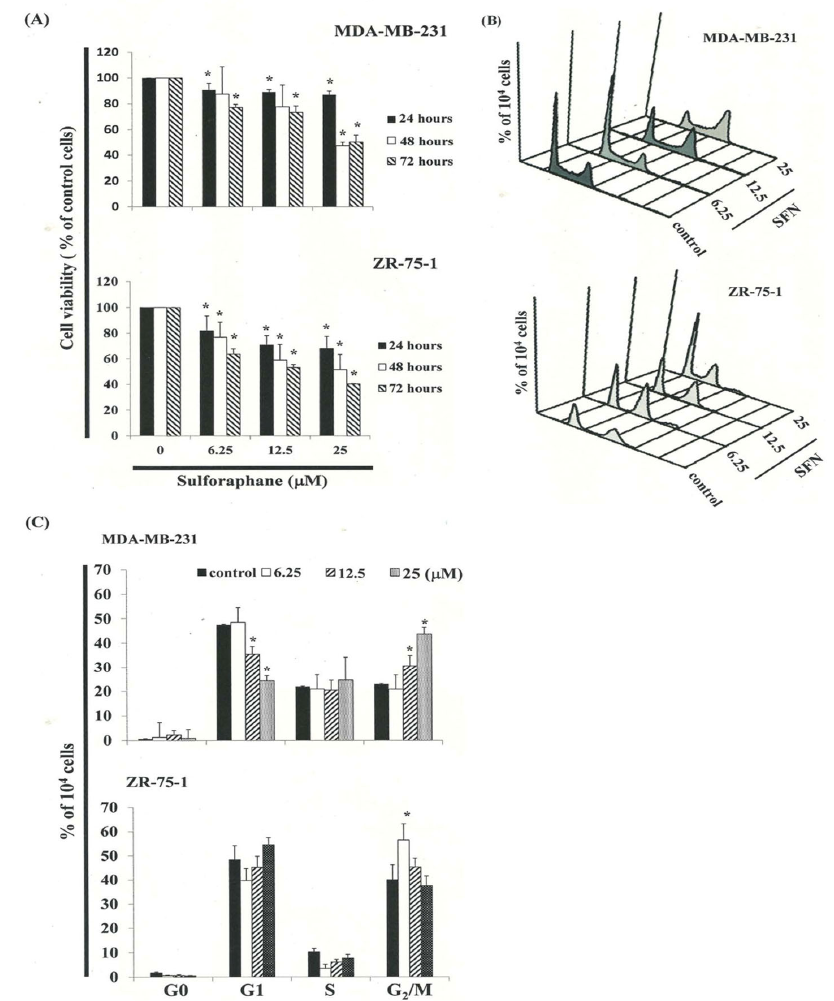
Figure 1. SFN mediates the survival of MDA-MB-231 and ZR-75-1 cells by inhibiting proliferation: ( A ) cells were treated with increasing doses of SFN (0, 6.25, 12.5, and 25 µM) for 24–72 h in vitro. The survival of SFN-treated cancer cells was measured using MTT assay. Results are expressed as a percentage of the control, considered to be 100%. All data are reported as the mean (±SEM) of at least three separate experiments. Statistical analysis was performed using the t test, with di ff erences between the treatment and control groups (0 µM SFN) considered signi fi cant at p < 0.05, delineated by *. E ff ect of SFN on cell cycle progression and distribution in MDA-MB-231 and ZR-75-1 cells: ( B ) cell cycle analysis of the cancer cells after being cultured with SFN for 24 h. ( C ) SFN induced an increase in G 2 /M-phase cell percentage (%). Cells were stained with propidium iodide to analyze DNA content, which was then quanti fi ed by fl ow cytometry. * in each group of bars indicates that the number of G 2 /M cells in the SFN treatment group was signi fi cantly higher than that of the control group ( p < 0.05).